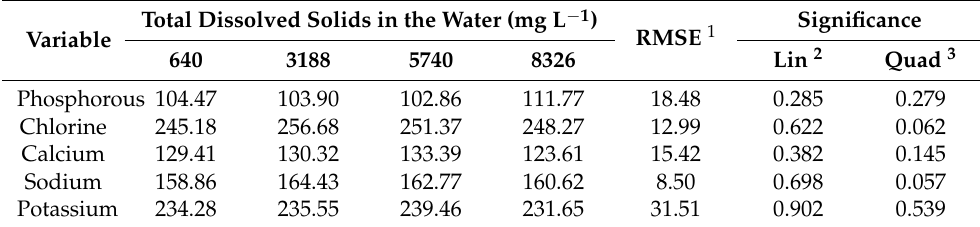
Table 5. Mineral composition of the milk of goats of the Alpine breed subjected to treatments with increasing levels of total dissolved solids over a period of 48 days of